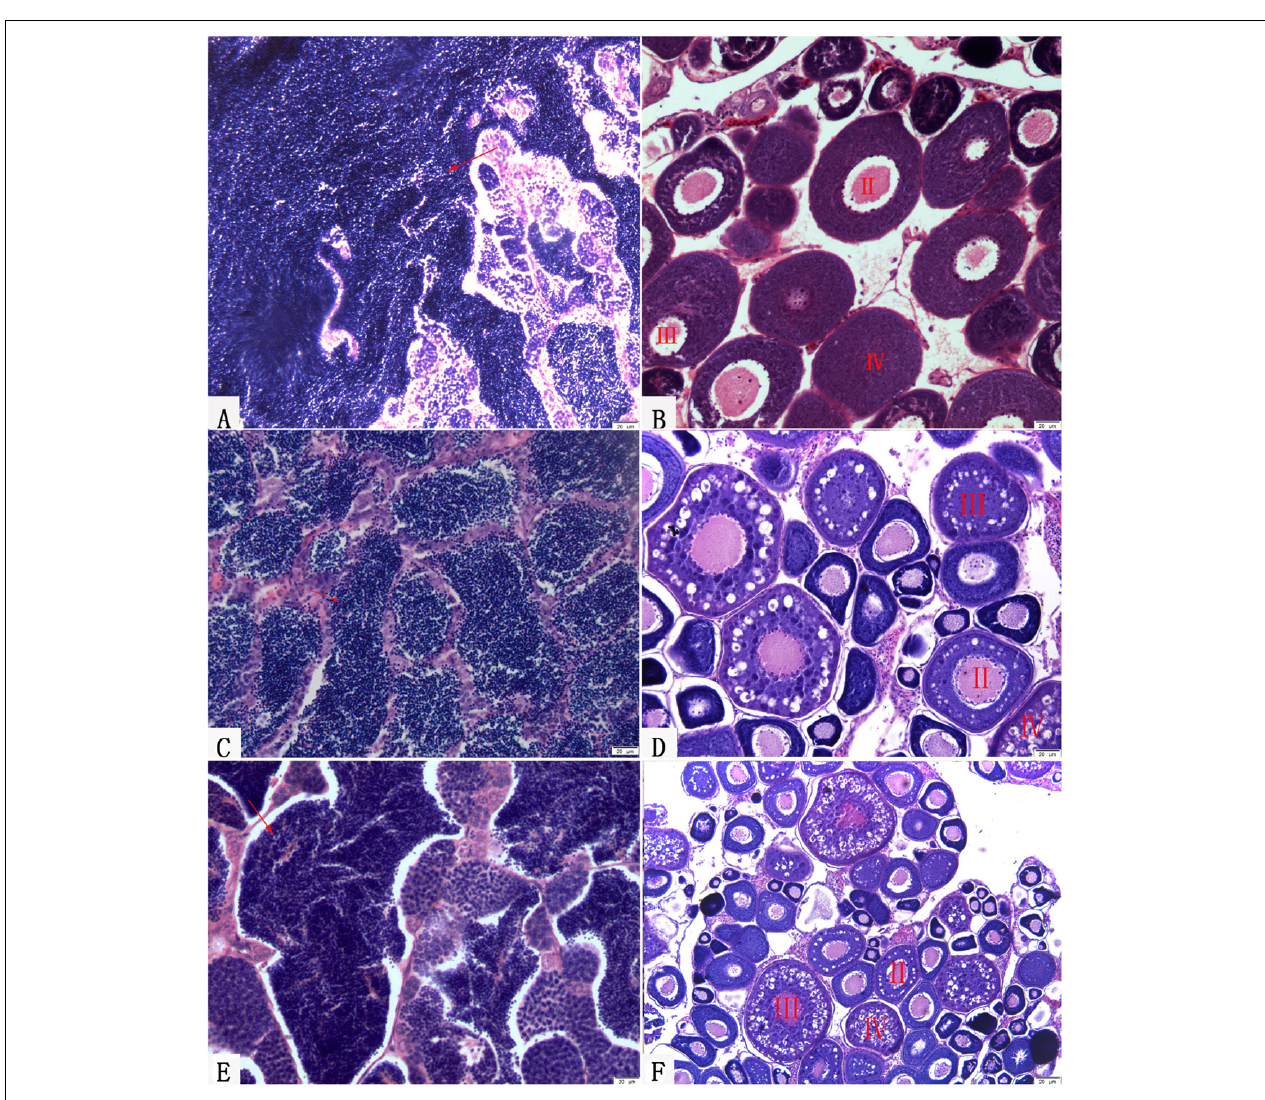
FIGURE 8 | Gonadal structure of BSB, KOC, RCC-L, and GF-L. (A) Mature testis of BSB containing mature spermatozoa, spermatids and spermatogonia. (B) Mature ovary of KOC including II-phase, III-phase, and IV-phase oocytes. (C) Mature testis of RCC-L containing mature spermatozoa, spermatids and spermatogonia. (D) Mature ovary of RCC-L including II-phase, III-phase, and IV-phase oocytes. (E) Mature testis of GF-L containing mature spermatozoa, spermatids and spermatogonia. (F) Mature ovary of GF-L including II-phase, III-phase, and IV-phase oocytes. Bar = 20 µ m.